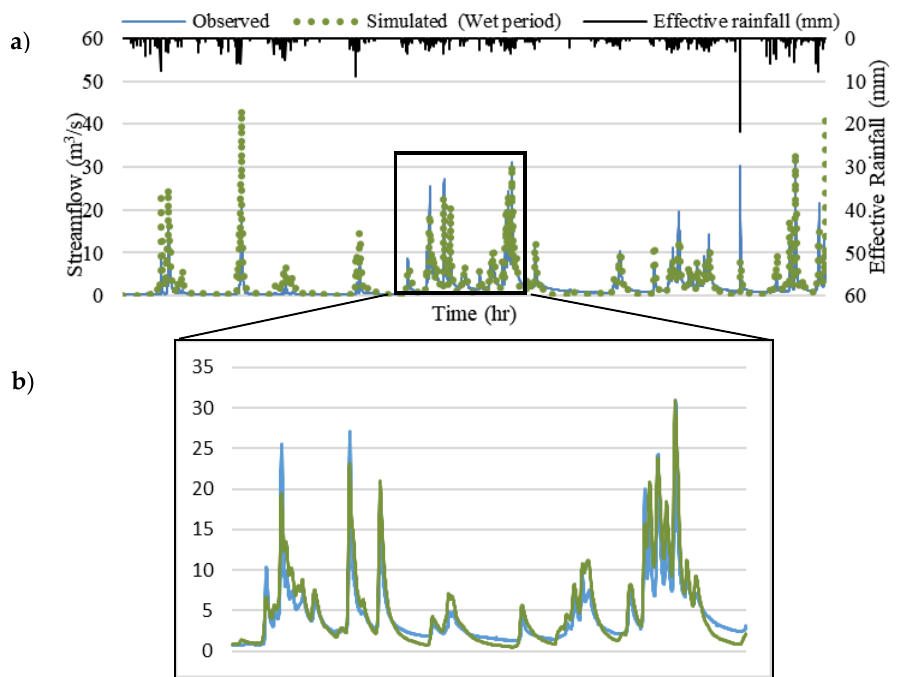
Figure 9. ( a ) Validation of the calibrated wet-period model; ( b ) zoomed in for a clear view.